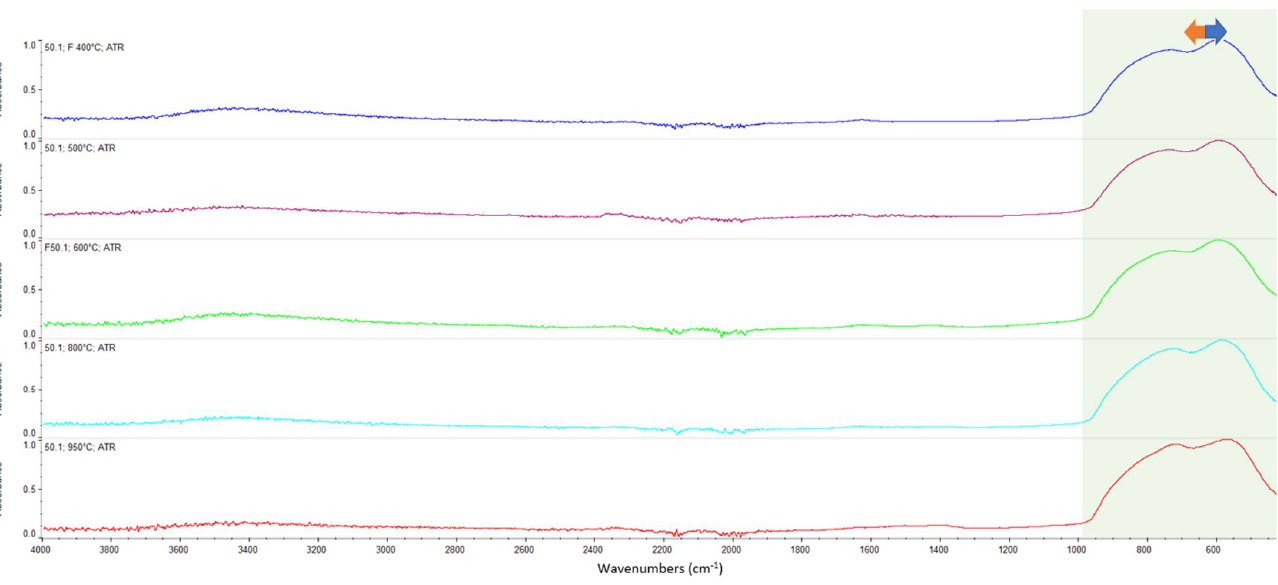
Figure A2. FTIR spectra of ashes of F50.1 at 950 °C (red), at 800 °C (light blue), at 600 °C (green), at 500 °C (purple), at 400 °C (blue).